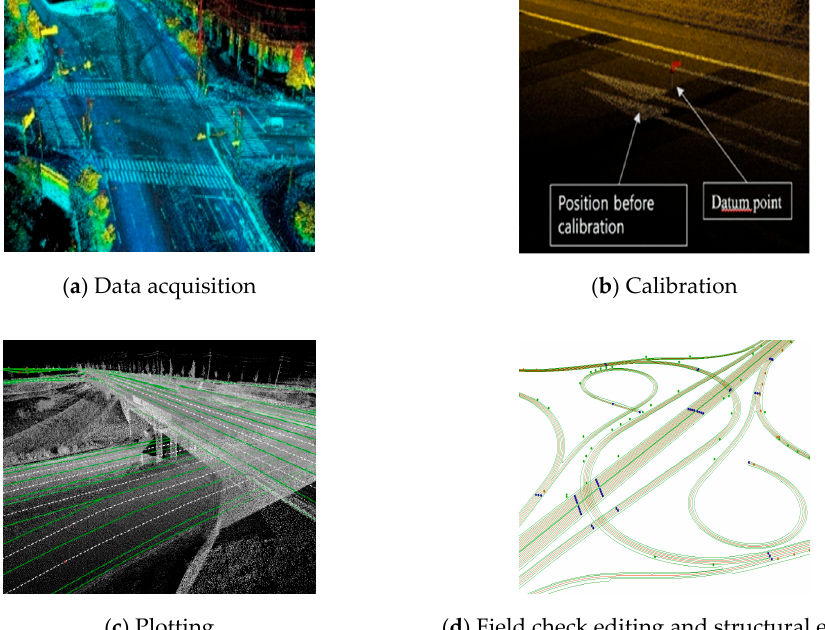
Figure 1. Creation of a high-precision digital map.